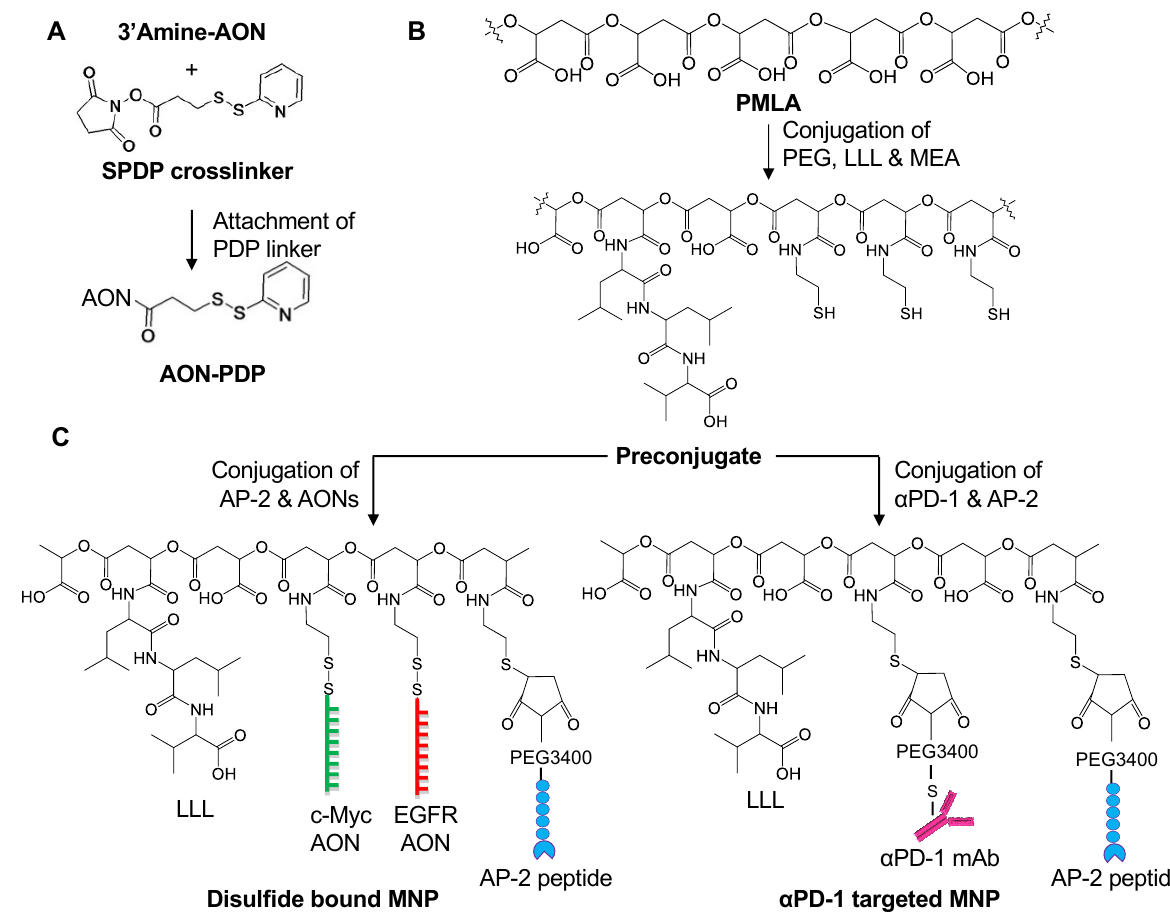
Figure 2. Synthesis of MNPs carrying disulfide bound (S-S) AONs to target c-Myc and EGFR, as well as α PD-1. ( A ) Synthesis of AON-PDP; ( B ) conjugation of PEG and LLL to PMLA (pre-conjugate); ( C ) synthesis of full